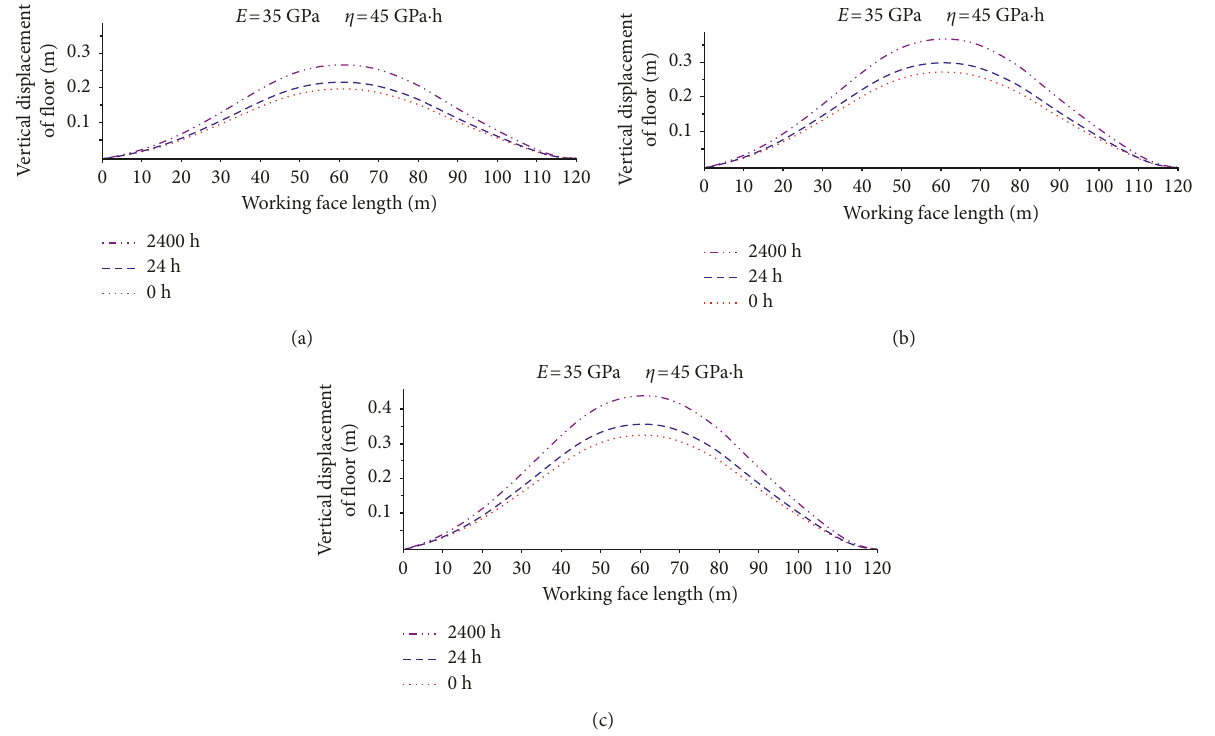
Figure 13: Deformation deflection curve with different water pressures. (a) p